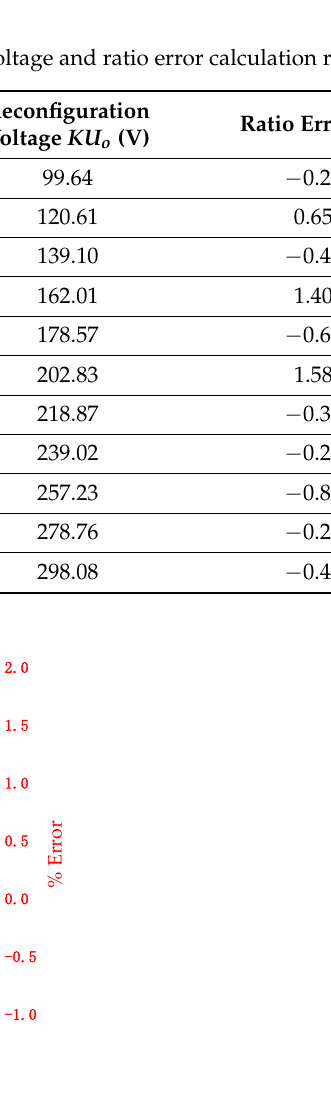
Figure 15. Sensor linearity and accuracy in low voltage scenarios.